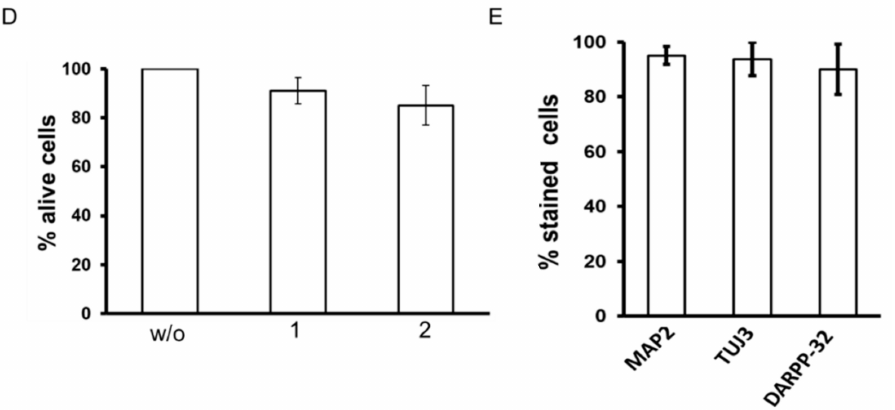
Figure 2. The effectiveness of modified reprogramming protocols. ( A ) Images illustrating morphology of induced neuron at 0 DIV, 7 DIV, 14 DIV, and 35 DIV. Light microscopy. Scale bars correspond to 100 µ m. ( B ) Representative images of fibroblasts stained with DAPI without transduction of lentiviruses ( w / o ), after 1 selection with antibiotics, and after re-plating on coverslips and secondary selection with antibiotics, according to the modified protocol. Scale bar corresponds to 50 µ m. ( C ) Representative images of iSNs reprogrammed according to the modified protocol and stained with antibodies to the neuronal markers and counterstained with DAPI. Immunofluorescent staining of induced neurons with antibodies for the neuronal marker protein TUJ1 (secondary antibodies conjugated with the Alexa 488 fluorophore), MAP2 (secondary antibodies conjugated with the Alexa 594 fluorophore), and DARPP-32 (secondary antibodies conjugated with the Alexa 488 fluorophore). Scale bar corresponds to 50 µ m. ( D ) Histogram represents the number of remaining cells without transduction of lentiviruses (w/o) after the first and second steps of selection. Data are presented as the mean ± SEM. n > 500 cells. ( E ) Histogram represents the number of the TUJ1-, MAP2-, DARPP-32-positive cells counterstained with DAPI and reprogrammed according to the modified protocol. Data are presented as the mean ± SEM. n > 250 cells for each